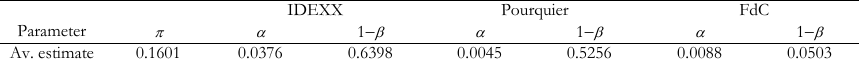
Simulation estimates settings for illness incidence and specificity and sensitivity of three